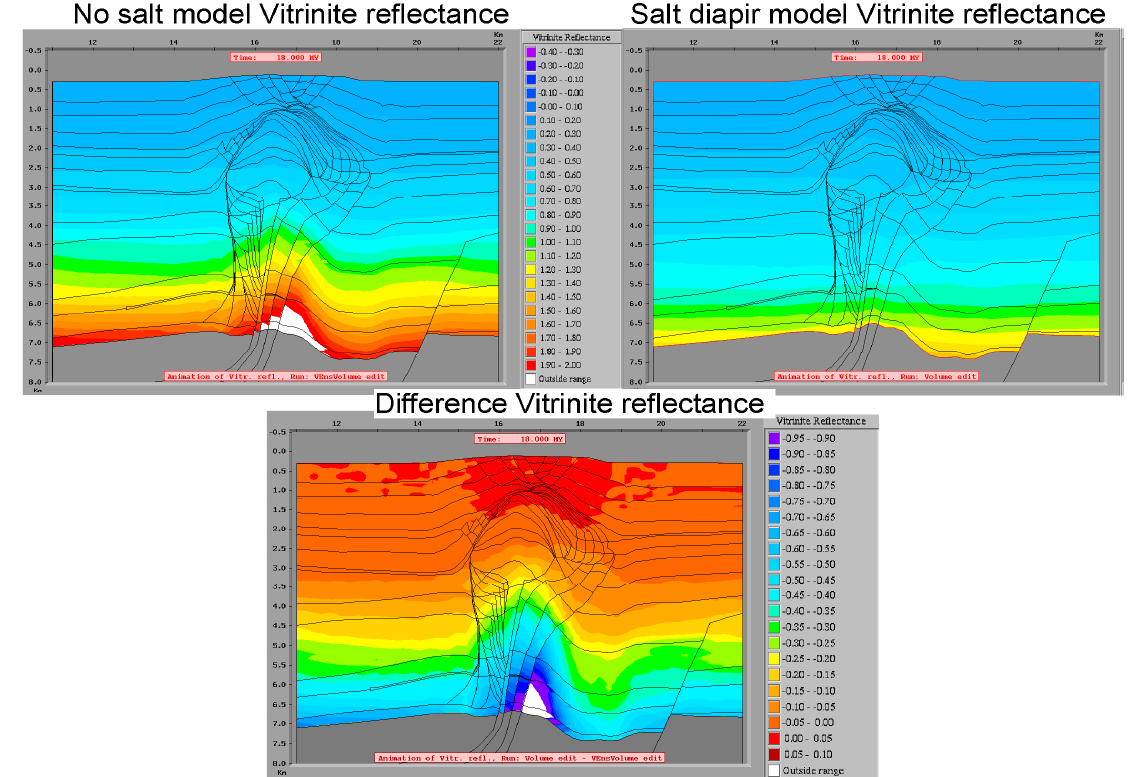
Figure 20. Top: Modeled vitrinite reflectance for Model 1 at 18 Ma, without salt balloon (top left) and model with salt balloon (top right). Lower figure shows the difference in modeled vitrinite reflectance between the two models.